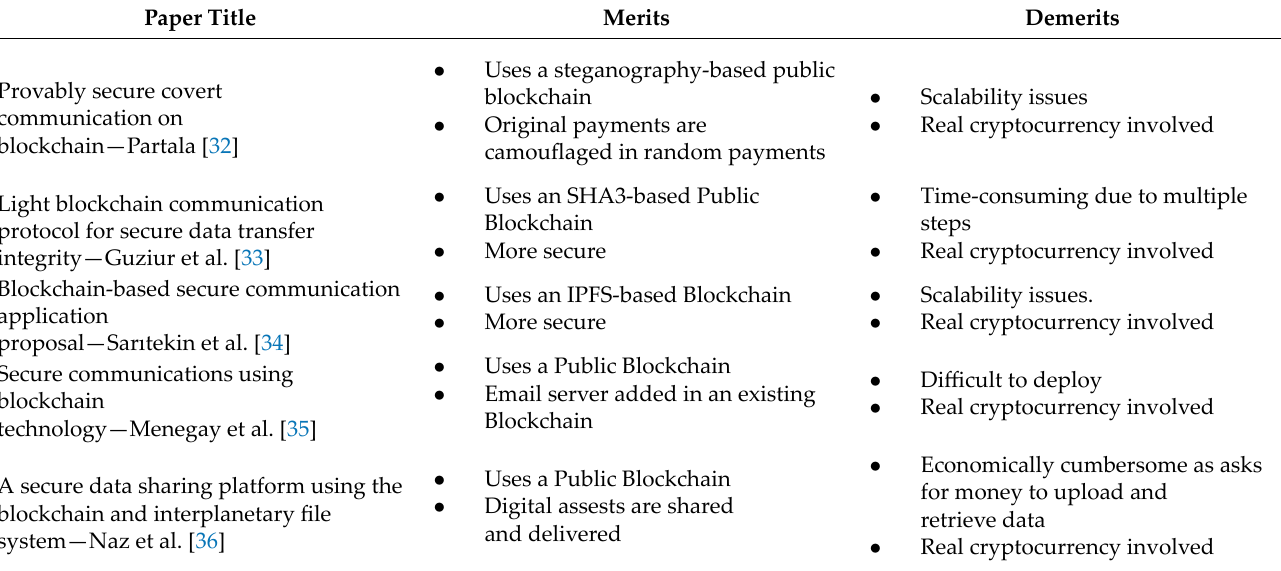
Table 3. Performance evaluation of existing Blockchain‑based Information Exchange